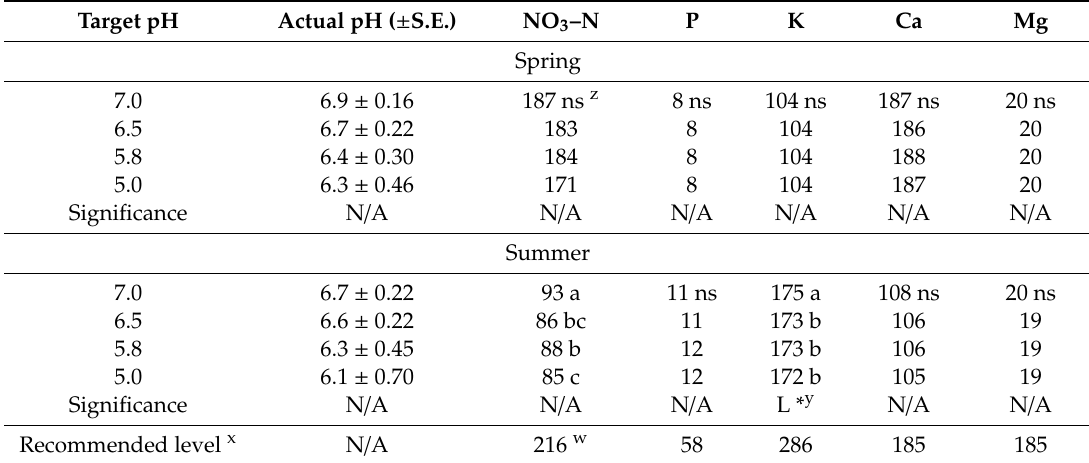
Table2. Midseason macronutrient analysis(mg · L –1 ) ofaquaponic irrigationwater at fourpH treatments.